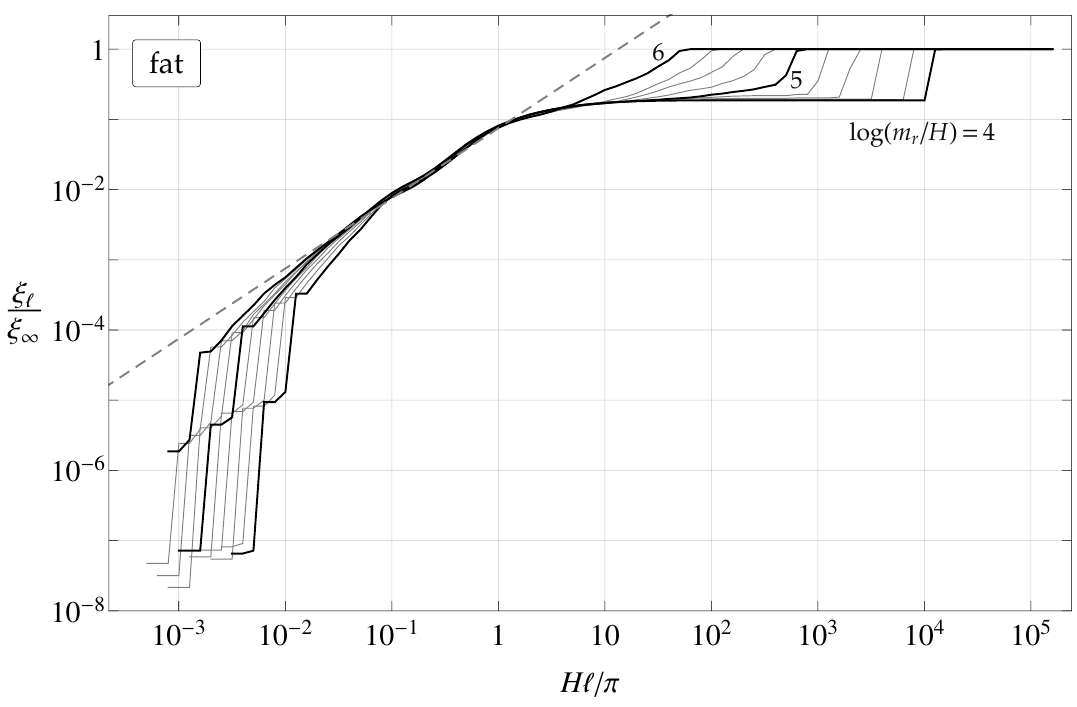
Figure 4 . The fraction of the total string length (cid:24) ‘ =(cid:24) 1 that is contained in loops smaller than ‘ for di(cid:11)erent time